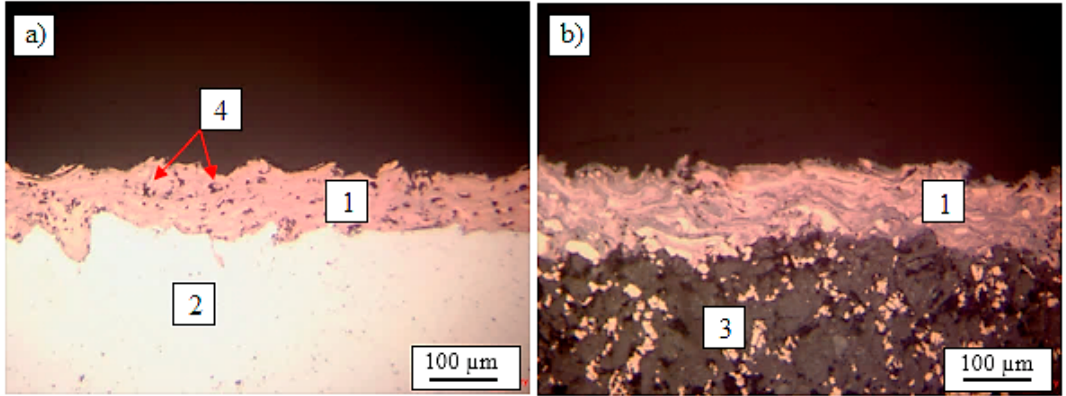
Figure 6. Plasma sprayed Cu coating on 6060 aluminum alloy ( a ) and on graphite composite substrate ( b ); 1—Cu coating; 2—6060 aluminum alloy; 3—graphite composite; 4—pores.